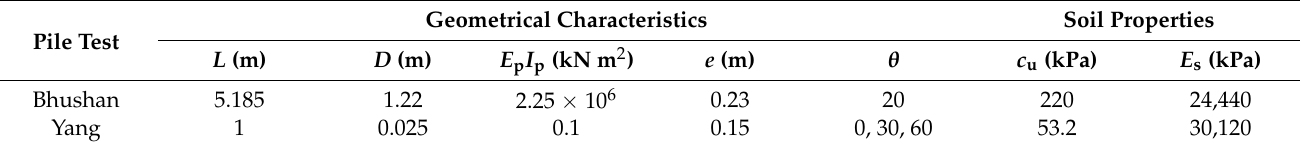
Table 5. Summary of pile load tests.